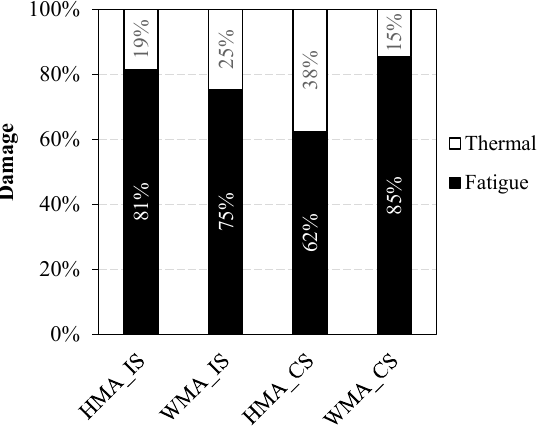
Figure 10. Influence of fatigue damage and thermal damage over the total damage obtained after 30 years.